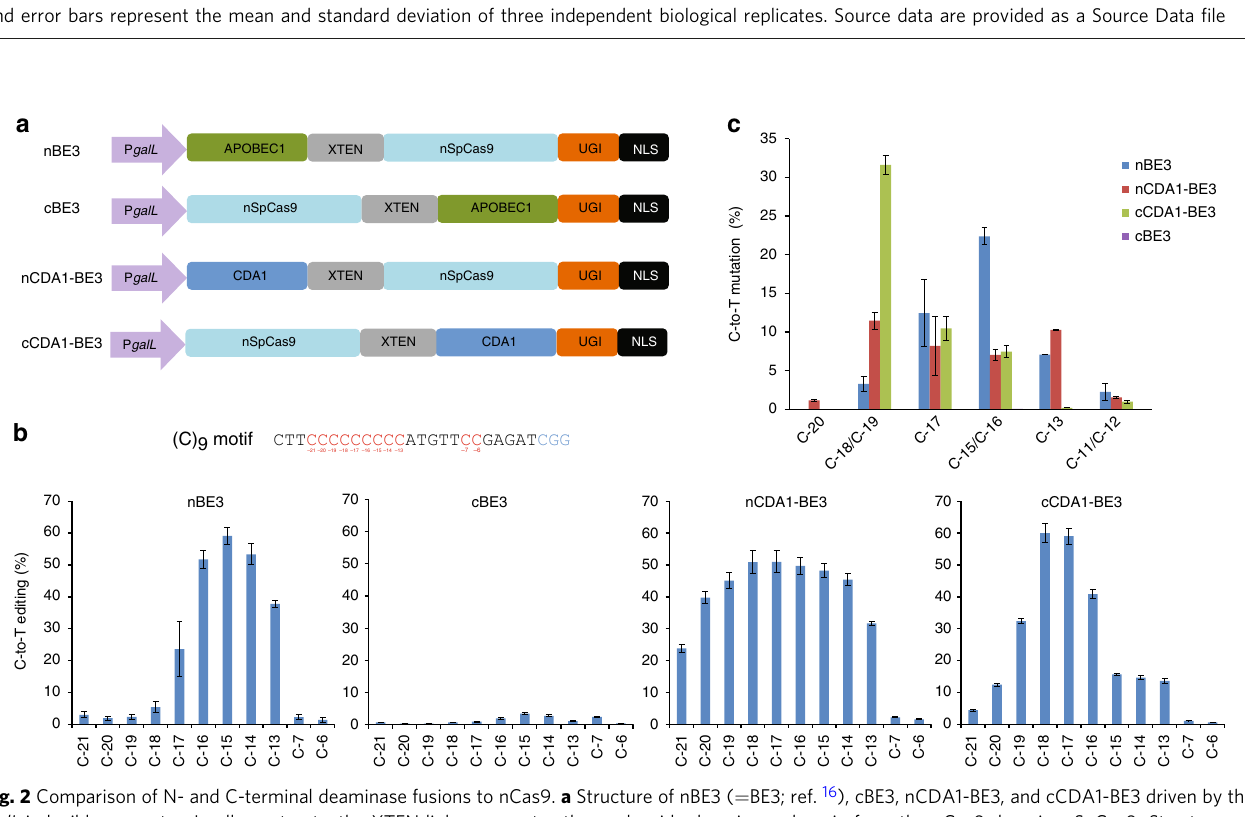
Fig. 1 Rigid linkers narrow the width of the editing window of BE3. a Protospacers and PAM (blue) sequences of the genomic loci tested, with the target Cs shown in red. Subscript numbers indicate the positions of the cytidines relative to the PAM. C-to-T editing at any of the indicated Cs inactivates the Can1 transporter and thus causes resistance to canavanine 17 . b Editing ef fi ciency and speci fi city of the base editors tested as determined by canavanine selection. The x -axis represents the target Cs within the protospacers. The y -axis shows their C-to-T editing frequency (see Methods and Supplementary Figure 1). Sequences of canavanine-resistant mutants aligned with the corresponding reference sequences are shown in Supplementary Figure 3. Values and error bars represent the mean and standard deviation of three independent biological replicates. Source data are provided as a Source Data fi